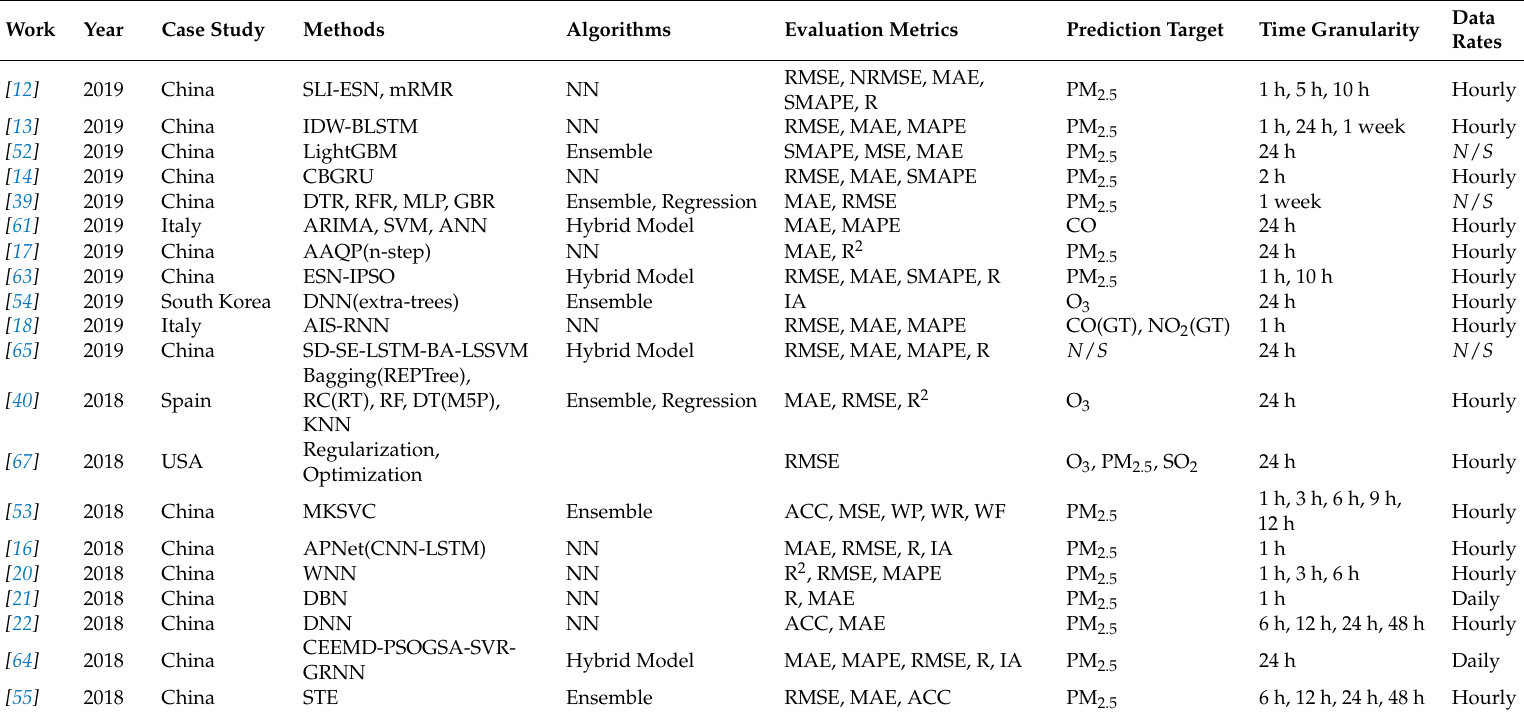
Table 2. Features of the selected papers. N / S : Not